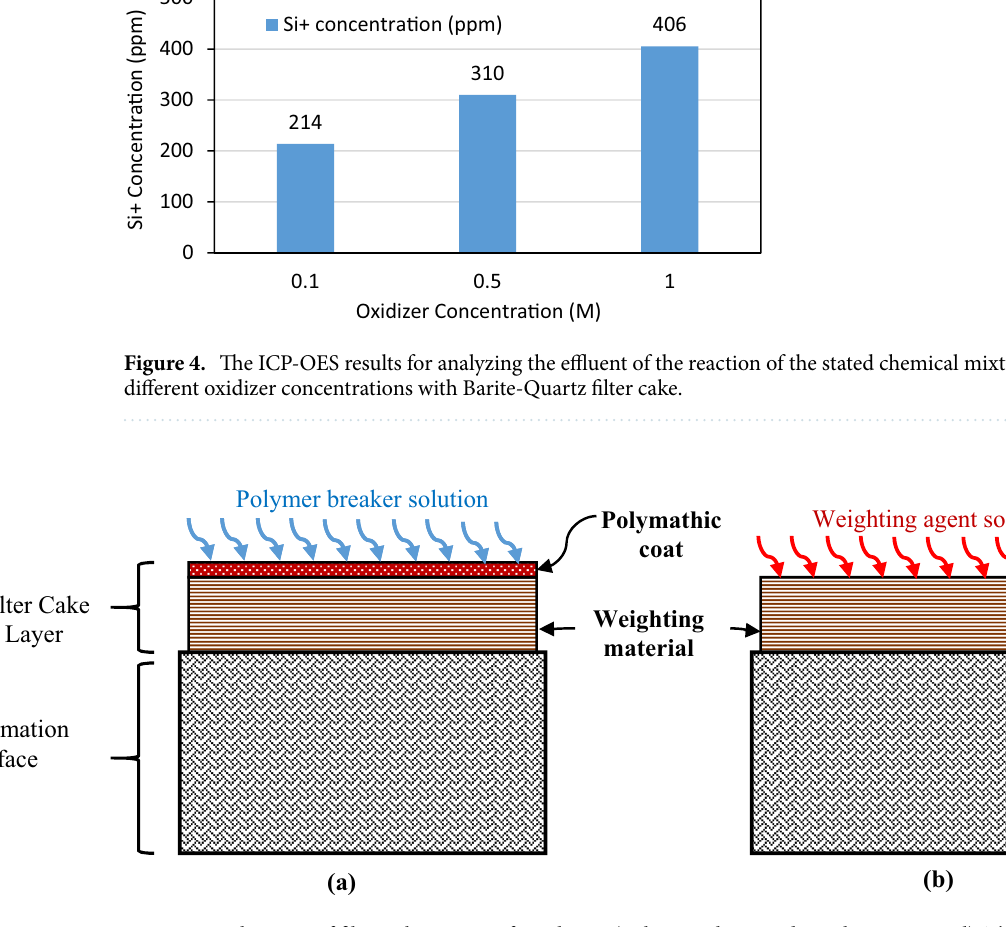
Figure 5. Schematic of filter cake consist of two layers (polymeric layer and weighting material). The removal process ( a ) breaks the polymer coated layer (thermochemical solution) and ( b ) dissolves the main filter cake layer (weighting